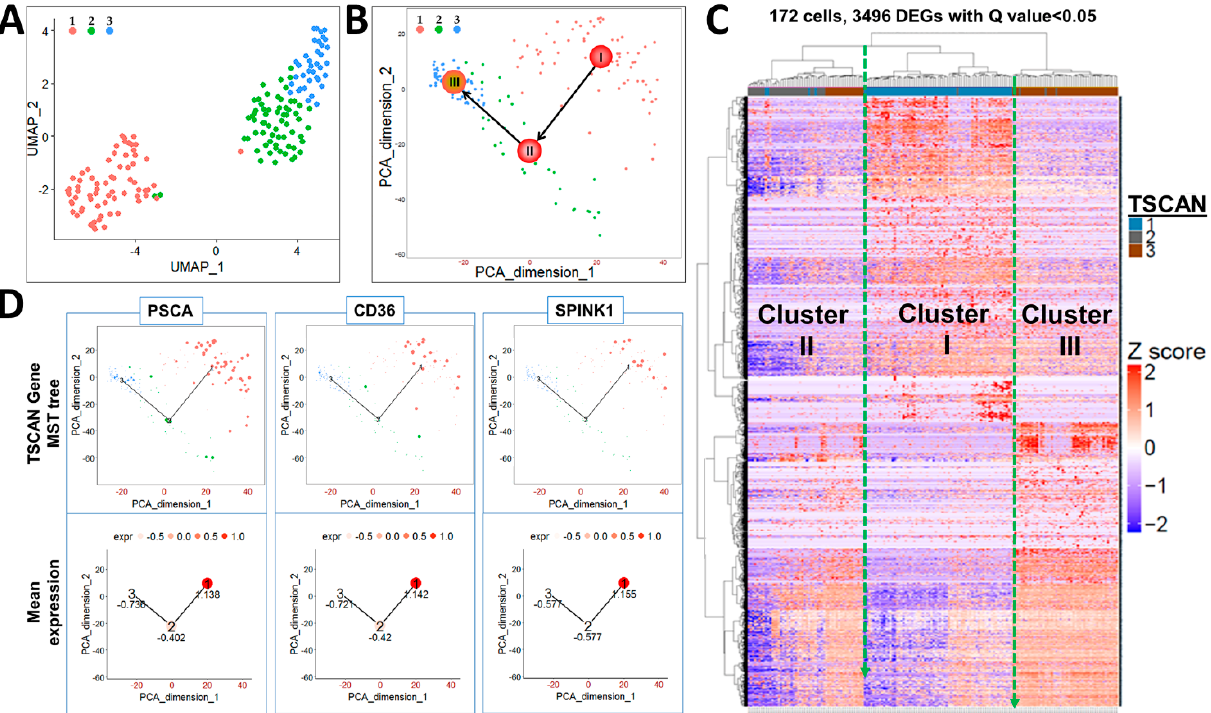
Figure 2. Single-cell RNA-seq of CFSE High cells revealed three subpopulations of cells. Data from Fluidigm C1 single-cell RNA-seq of CFSE High isolated prostasphere cells was analyzed by UMAP ( A ) and TSCAN ( B ) principal component analyses, which identified three major cell clusters that were further confirmed by unsupervised heatmap clustering ( C ). CFSE High cell hierarchical clustering ( I (1) → II (2) → III (3)) was ordered by MST-based pseudo-time reconstruction to mimic true biological time, identifying cells in cluster I as originating cells which yield cluster II that then yield cluster III (labeled in B). ( D ) Known stemness genes PSCA , CD36 , and SPINK1 are enriched in cluster I (1) as compared to clusters II (2) & III (3), which is demarcated by a circle size (top) that represents gene expression levels that are relatively quantified at the